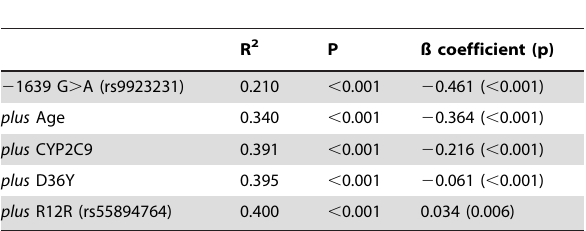
Table 4. Summary of the additive regression model (stepwise method): predictor contribution to steady therapeutic dose of acenocumarol in 3949 anticoagulated